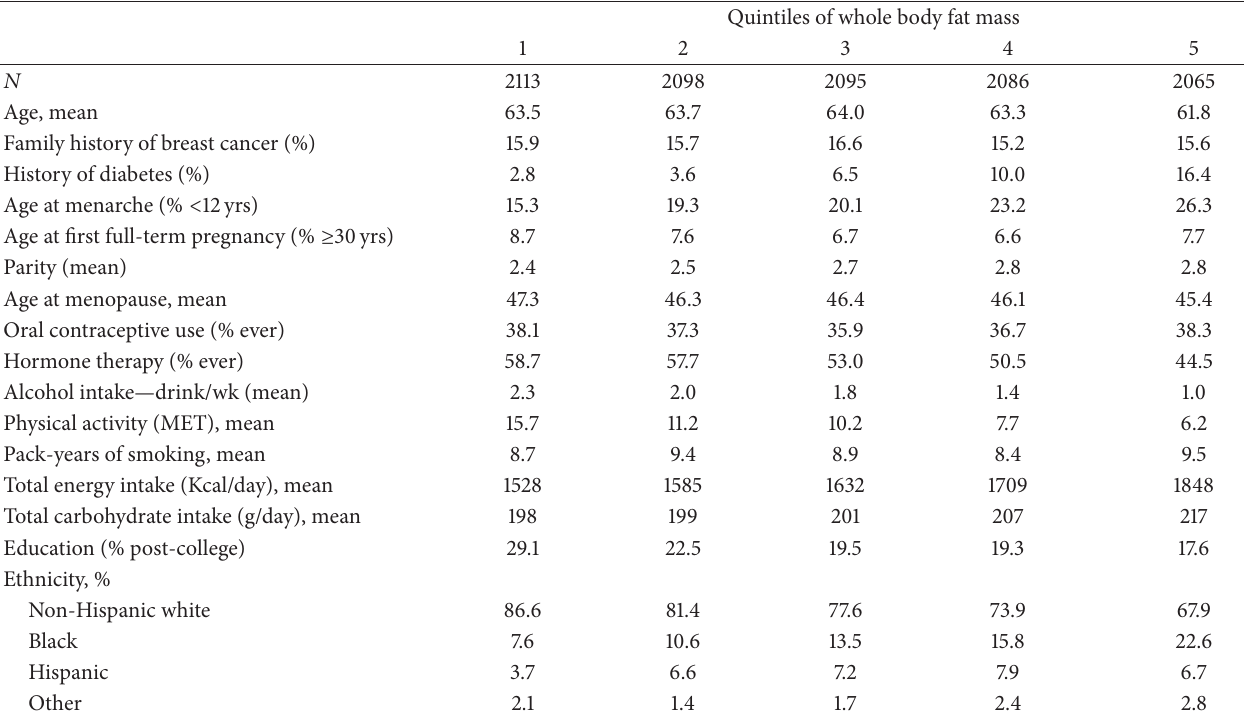
Table 2: Distribution at baseline of selected characteristics by quintiles of DXA-derived whole body fat mass among non-cases ( 𝑁 =